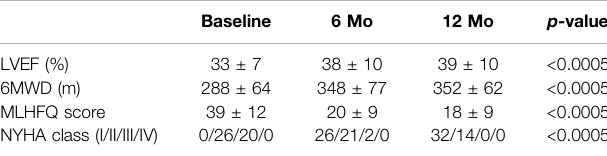
Abbreviations as in text. p -values are two-sided and are based on paired t-tests for 12 month comparison with baseline. From Premchand RK et al. J Card Fail 2016; 22: 639 – 42, with